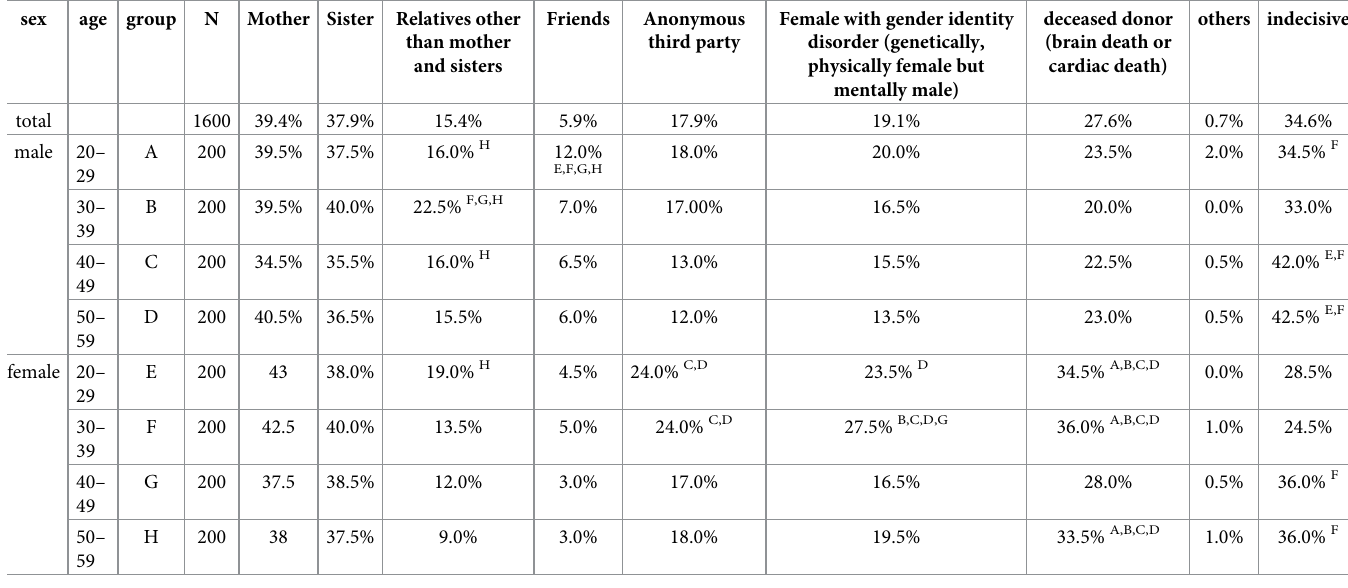
Table 6. Who is eligible to be a donor of